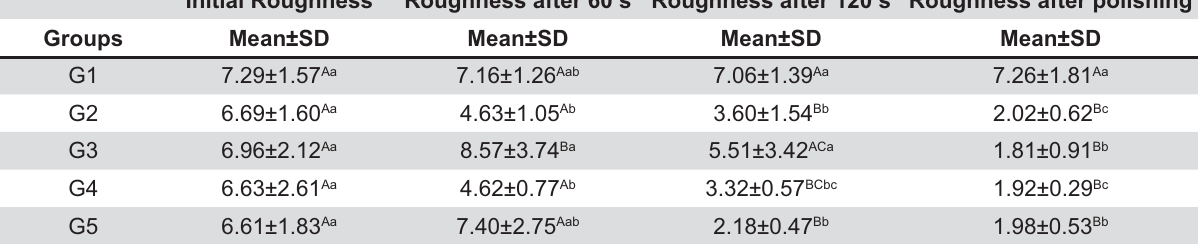
Different lower case letters indicate differences between columns and different capital letters indicate differences between rows Table 2-